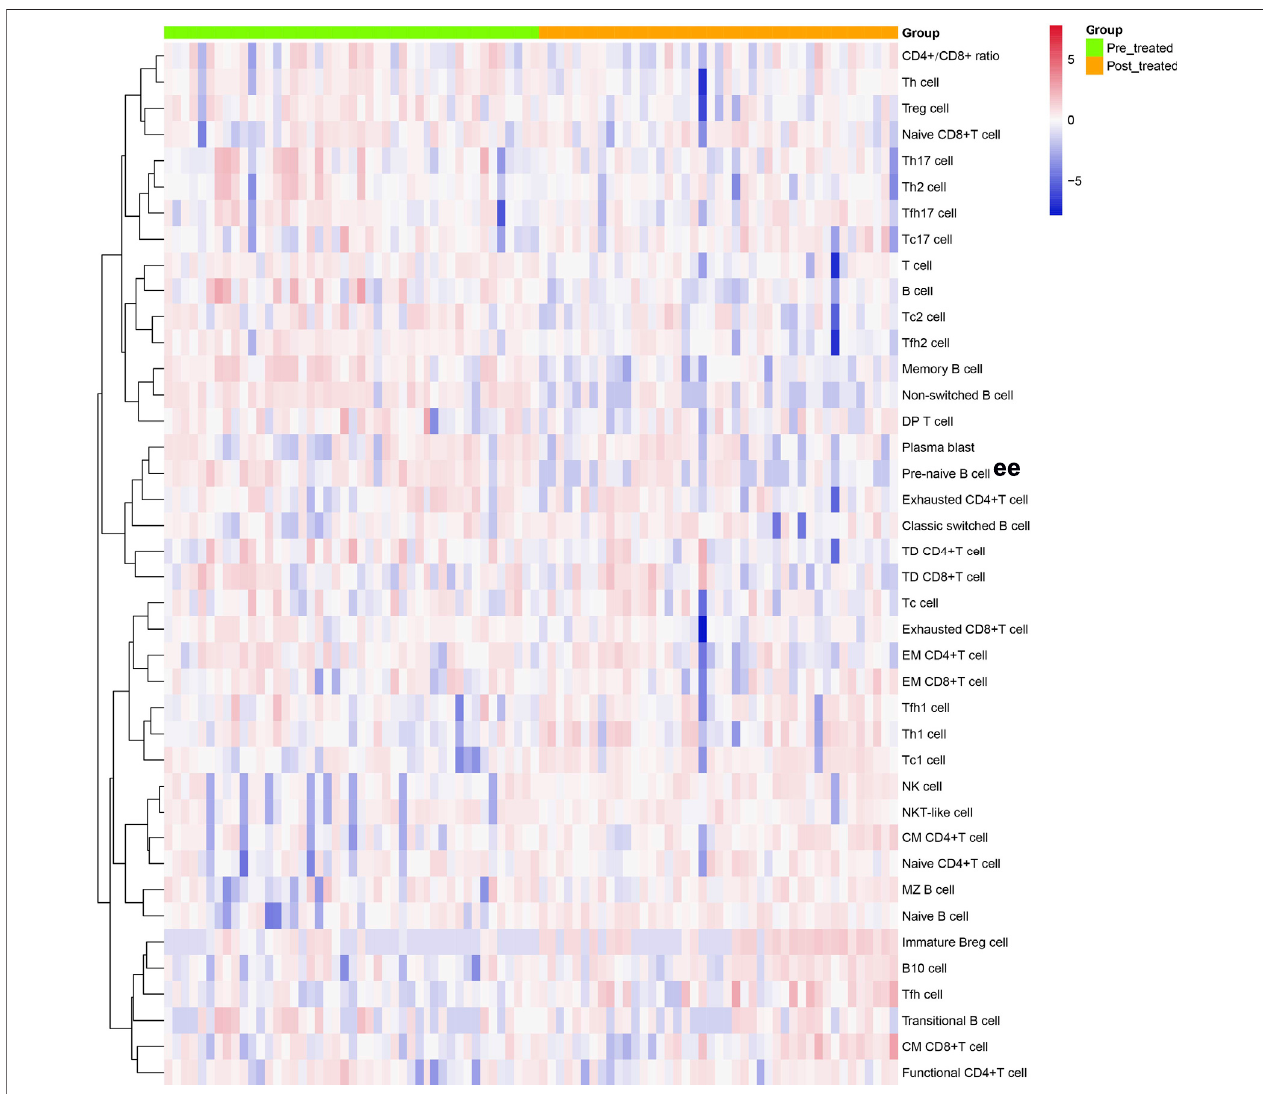
FIGURE 1 | Cluster analyses of immune cell frequency in the patients with AS before and after treated with secukinumab. Each column represented individual patients with AS. Pre-treatment group was marked as green and post-treatment group was marked as orange. The rows represented immune cell subsets that are differentially expressed. The magnitude of parameter expression was color-coded with red for an increase in expression and blue for a decrease in expression. Th cell, helper T cell; Treg cell, regulatory T cell; Tc cell, cytotoxic T cell; Tfh cell, follicular helper T cell; DP T cell, double positive T cell; TD, terminally differentiated; EM, effector memory; CM, central memory; NK cell, natural killer cell; Breg cell, regulatory B cell.